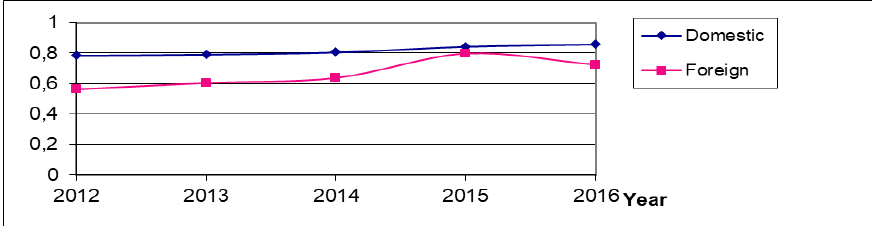
Figure 5: Comparison between domestic banks and foreign banks by using an annual average of loan to deposit ratio for year 2012-2016